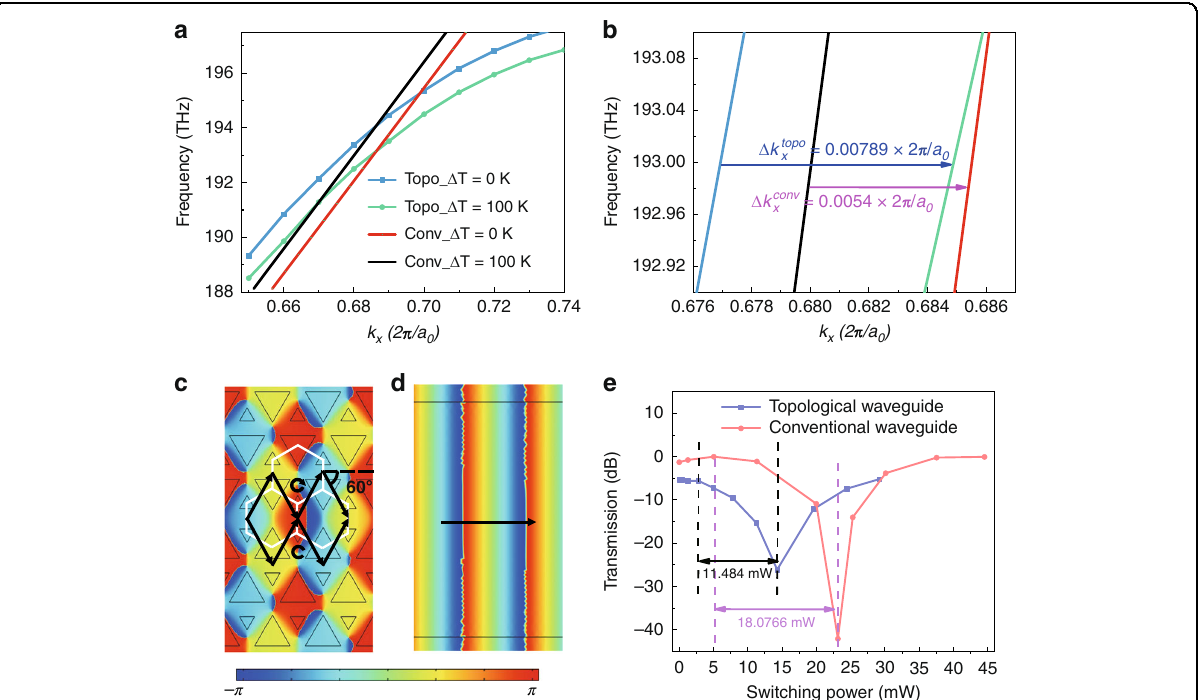
Fig. 2 Principle and characterization of the topological phase shifter. a Temperature-dependent dispersion relations of the conventional mode and topological mode localized at edge 1. b Phase change of the conventional mode and topological mode with a temperature change of 100 K at 193 THz ( λ = 1550 nm). c , d The Hz phase of the topological mode in edge 1 and the TE 0 mode in the conventional waveguide. The black arrow represents the direction of light propagation. e Switching characteristics of the topological waveguide and the conventional waveguide at the wavelength λ = 1550